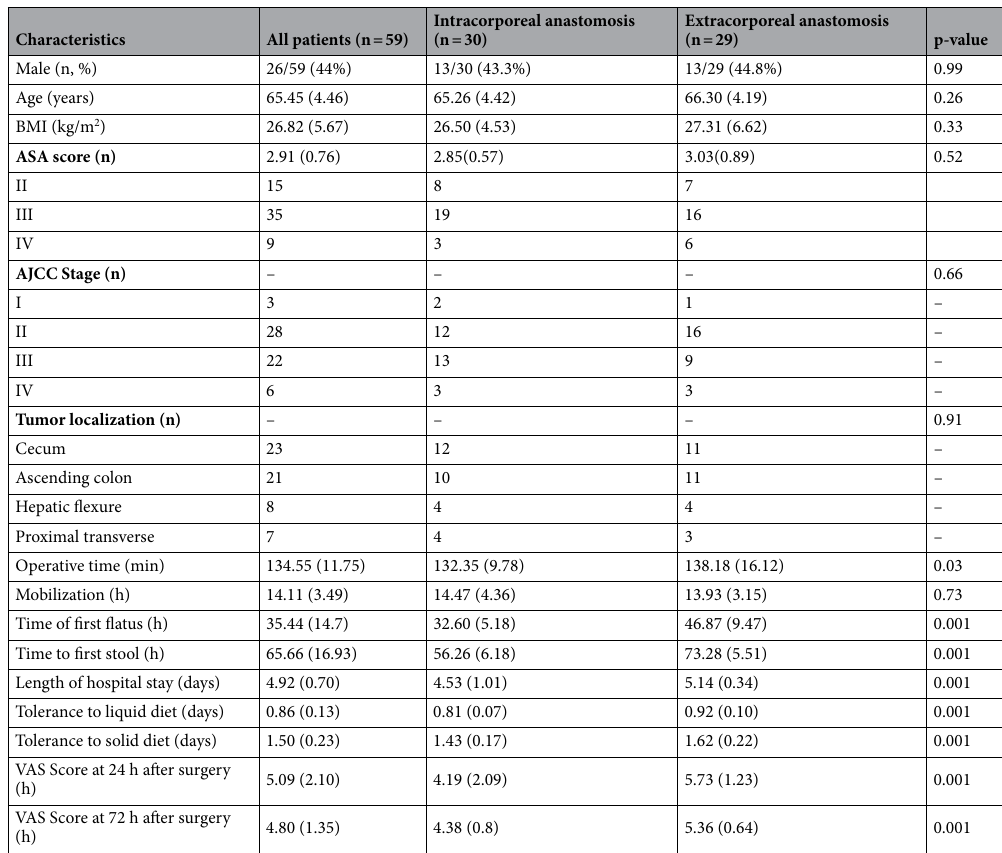
Table 1. Demographic characteristic and recovery outcomes of all randomized patients. Data were expressed as median (interquartile range) where nor differently indicated. BMI body mass index, ASA American Society of Anesthesiologists, AJCC American Joint Committee on